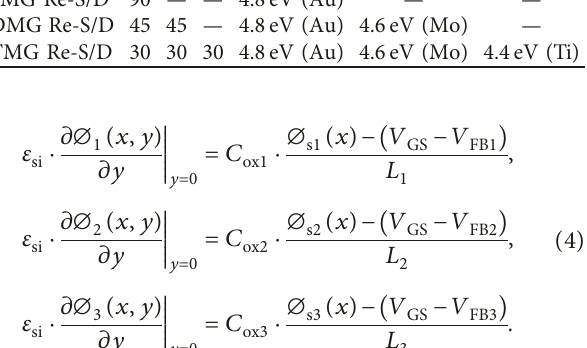
Table 1: Device structure of SMG, DMG, and TMG Re-S/D SOI MOSFET. Device SMG Re-S/D 90 — — 4.8eV